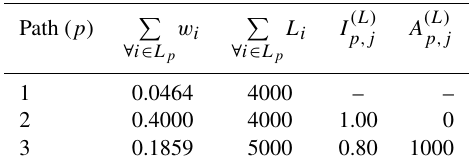
Table 1. Summary of results for the three shortest-path analyses from s to j , Fig.